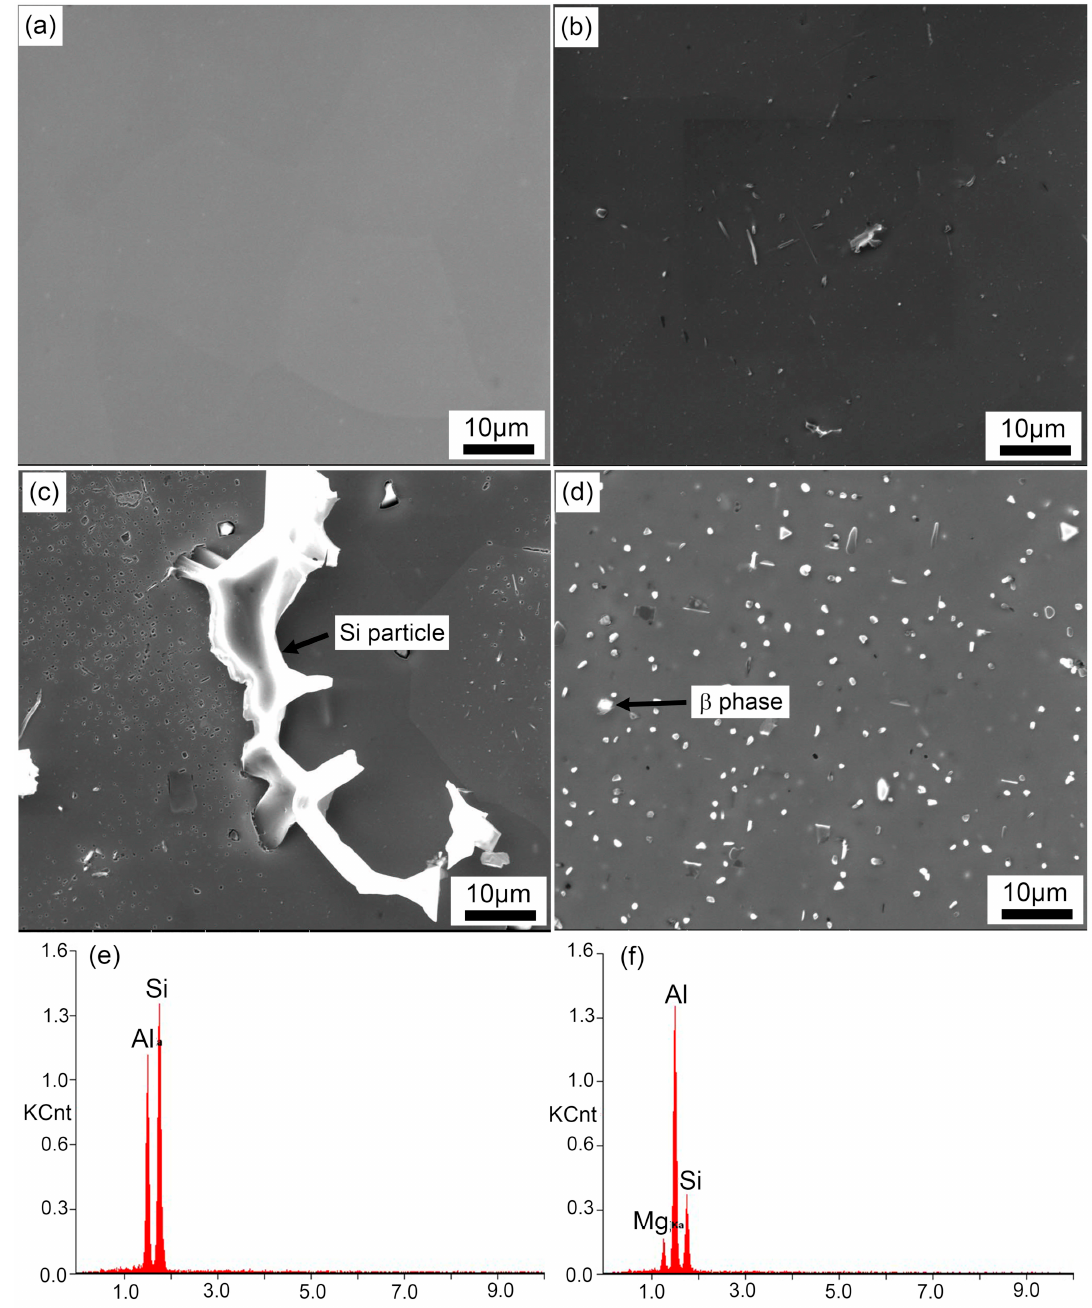
Figure 4. Scanning electron microscope (SEM) micrographs and energy dispersive spectrometer (EDS) analysis of particles distributed in samples with different quenching rates after pre-aging treatment: ( a ) 58.9 °C/s, ( b ) 2.8 °C/s, ( c ) 0.01 °C/s, ( d ) annealing treatment, ( e ) EDS spectra of Si phase, and ( f ) EDS spectra of β phase.